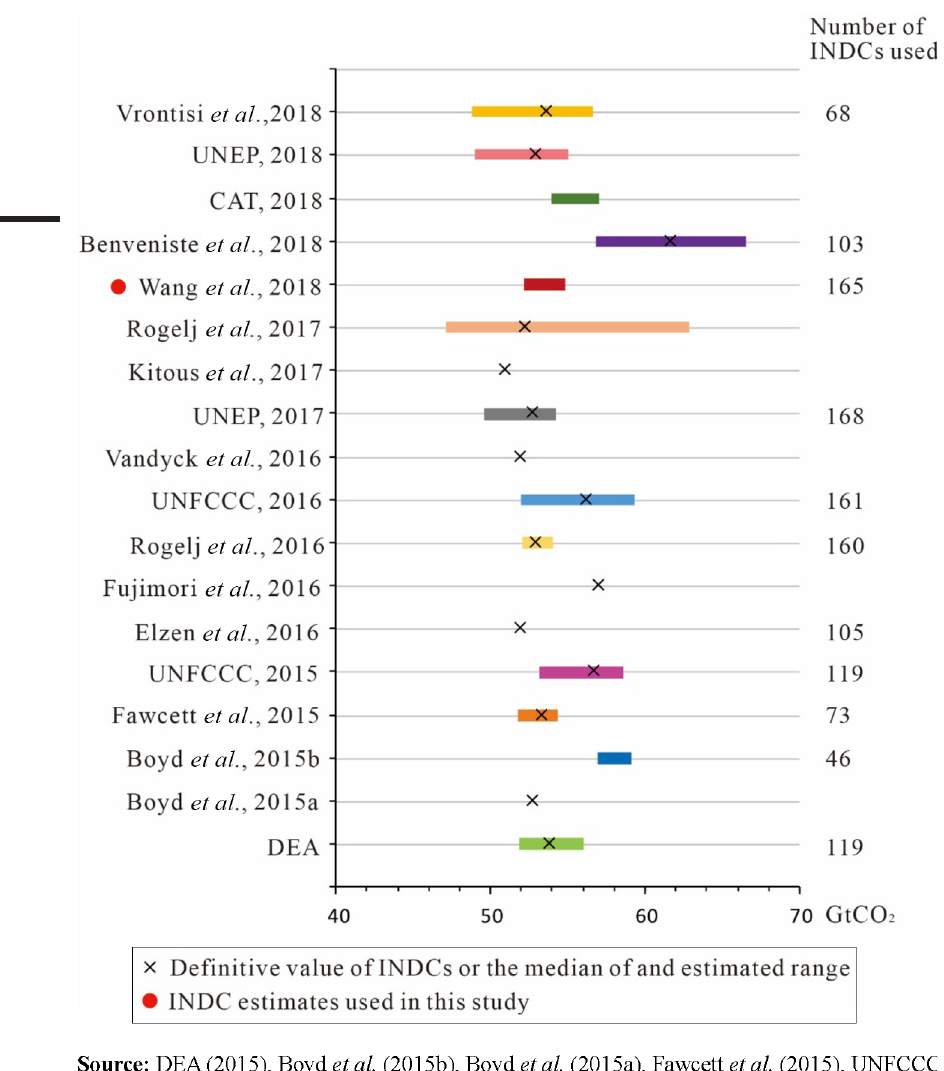
Figure 1. Some quantitative results of INDCs in existing